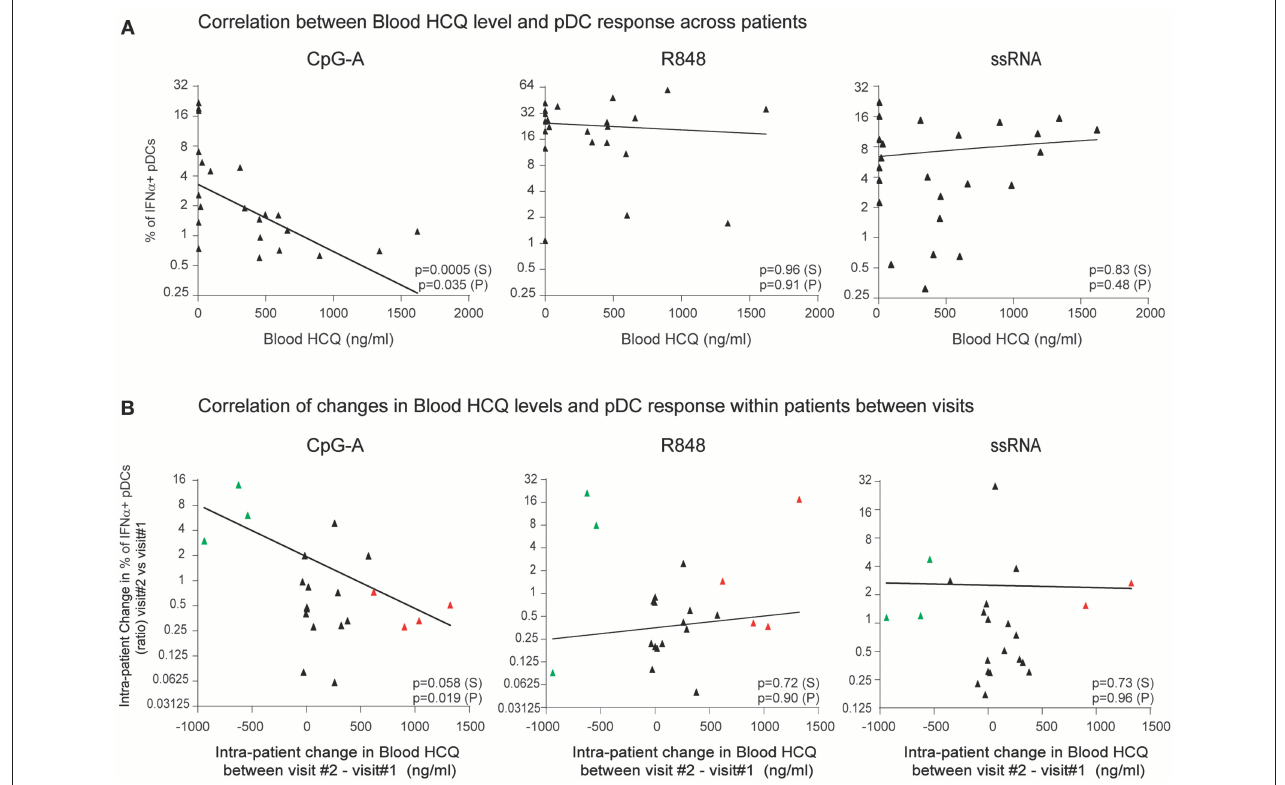
FIGURE 3 | The percentage of IFN α -producing pDCs upon stimulation with CpG-A, but not R848 or ssRNA, is negatively correlated with whole blood HCQ concentrations from CLE patients. (A) Association of the percentage of IFN α -producing pDCs identified by flow cytometry from PBMC after CpG-A ( n = 22 donors), R848 ( n = 22 donors), or ssRNA ( n = 24 donors) stimulations with the HCQ concentrations in whole blood from CLE patients. Patients with non-detectable blood HCQ levels are shown at 0ng/ml blood HCQ (B) Association of the change (ratio) between 3-month apart clinical visits in the percentage of IFN α -producing pDCs identified by flow cytometry from PBMC after CpG-A ( n = 21 donors), R848 ( n = 21 donors), or ssRNA ( n = 22 donors) stimulation with the change in the blood HCQ concentration of CLE patients. Data points from patients with increase in blood HCQ concentration > 600ng/ml between the two visits are highlighted in red. Data points from patients with decrease in blood HCQ concentration > 500ng/ml between two visits are highlighted in green. Statistical association was assessed using Pearson’s (P) and Spearman’s rank (S)